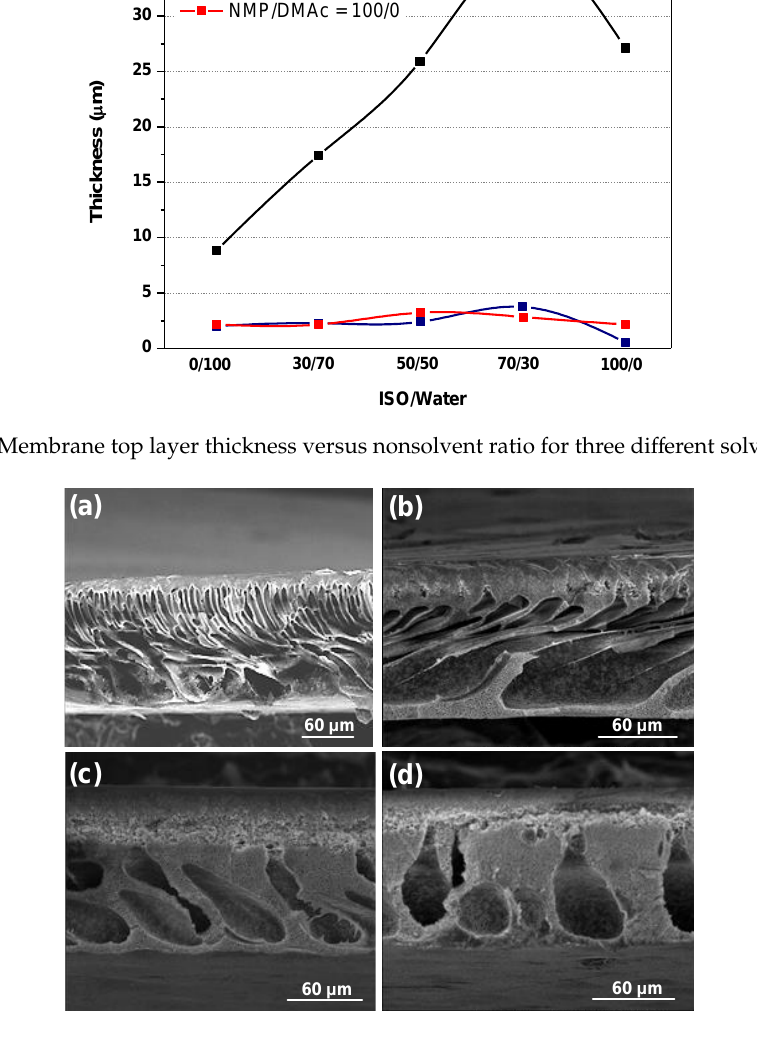
Figure 5. Membrane prepared with DMAc as the solvent by coagulation into mixtures of water and isopropanol (concentration of isopropanol indicated): ( a ) 0% Iso, ( b ) 50% Iso, ( c ) 70% Iso, and ( d ) 100% Iso.